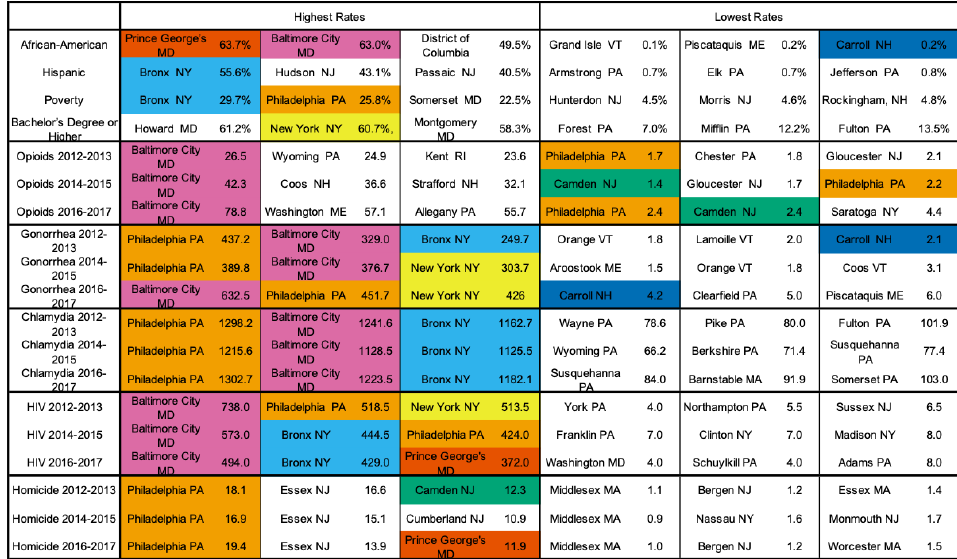
Figure A8. Displays counties with the top three highest and bottom three lowest rates for each variable tested. Colored squares indicate counties appearing across multiple variables. Philadelphia, PA ranks high for poverty, all STIs, and homicide, but low for opioid deaths. Low opioid deaths in these counties may be attributed to a different classification system for drug-related death, but more investigation is needed.